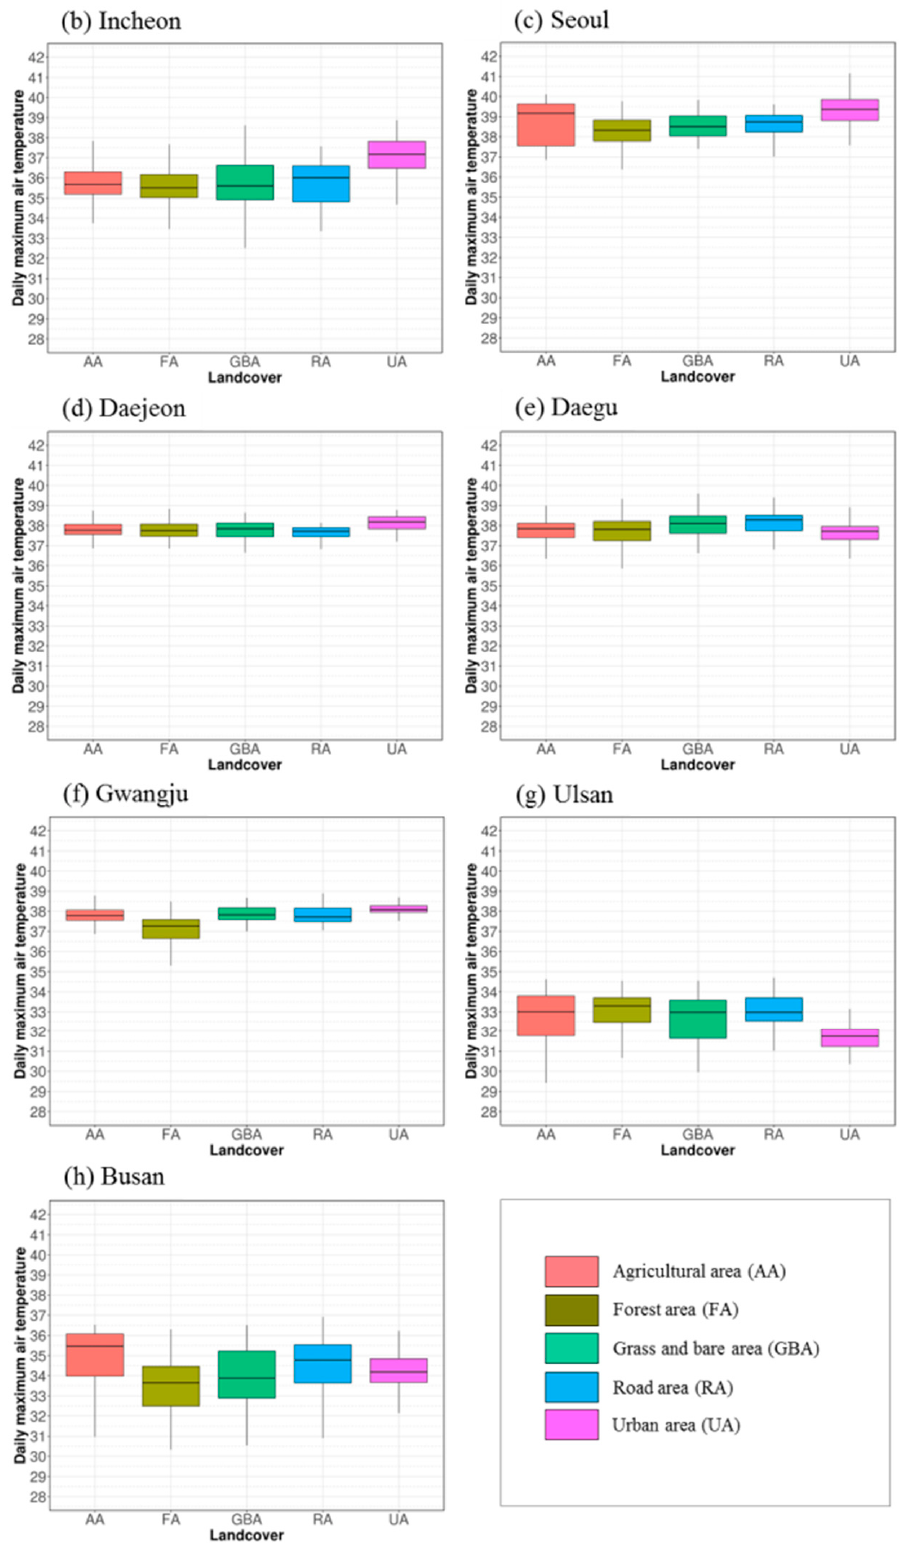
Figure 9. Daily maximum temperature distribution on 1 August 2018 with respect to the land use in each city. ( b ) Incheon; ( c ) Seoul; ( d ) Daejeon; ( e ) Daegu; ( f ) Gwangju; ( g ) Ulsan; ( h ) Busan. ( b – h ) are the analysis areas shown in Figure